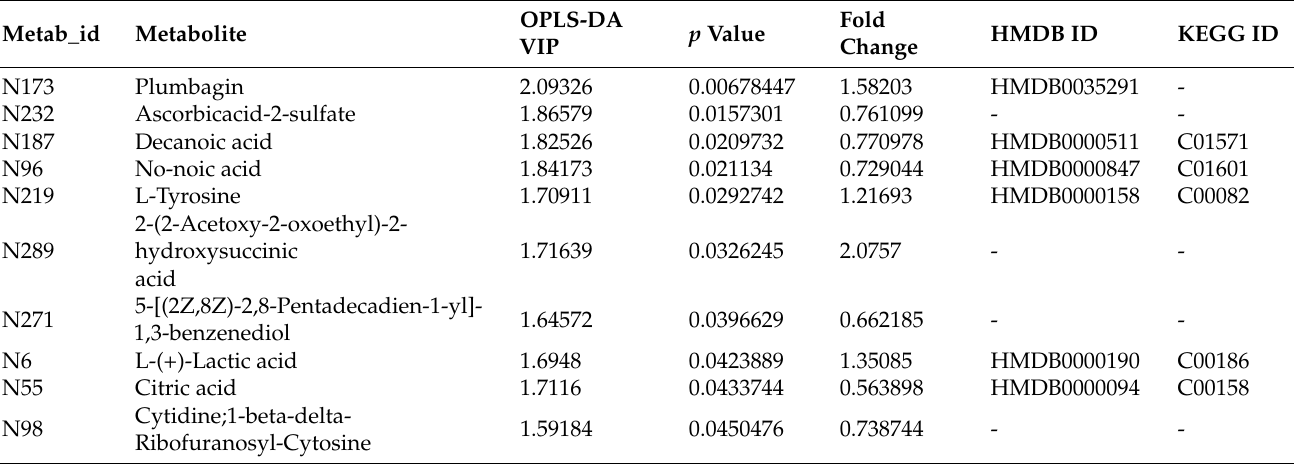
Figure 4. Metabolic alterations were identified in B. breve CCFM1025 compared with the model group in ESI − mode. ( A ) OPLS-DA score plots for serum (up) and hippocampus (down) samples. The X and Y axis represent the contribution of the first two principal components (PC1 and PC2). ( B ) Cross- validation plot for the serum (up) and hippocampus (down) OPLS-DA model with a permutation test repeated 200 times. The intercepts of R2 = (0.0, 0.785) and Q2 = (0.0, –0.351) and R2 = (0.0, 0.849) and Q2 = (0.0, –0.283) suggest that the OPLS-DA model is not overfitting. ( C ) Volcano plots showing the results of pairwise comparisons of serum (up) and hippocampal (down) metabolites in the B. breve CCFM1025 and model group. Metabolites with significant changes are presented in red (upregulated) or green (downregulated). ESI − : negative electrospray ionization; OPLS-DA: orthogonal partial least squares discrimination analysis. Table 1. The significantly altered metabolites in serum between the CCFM1025 and model